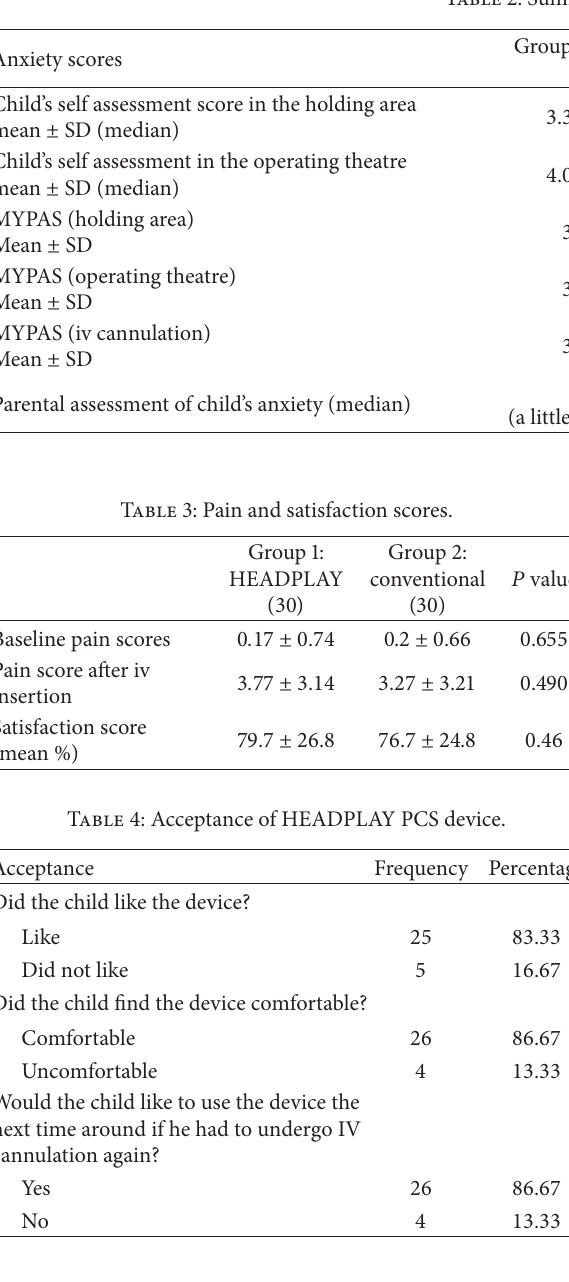
Table 2: Summary of anxiety scores.